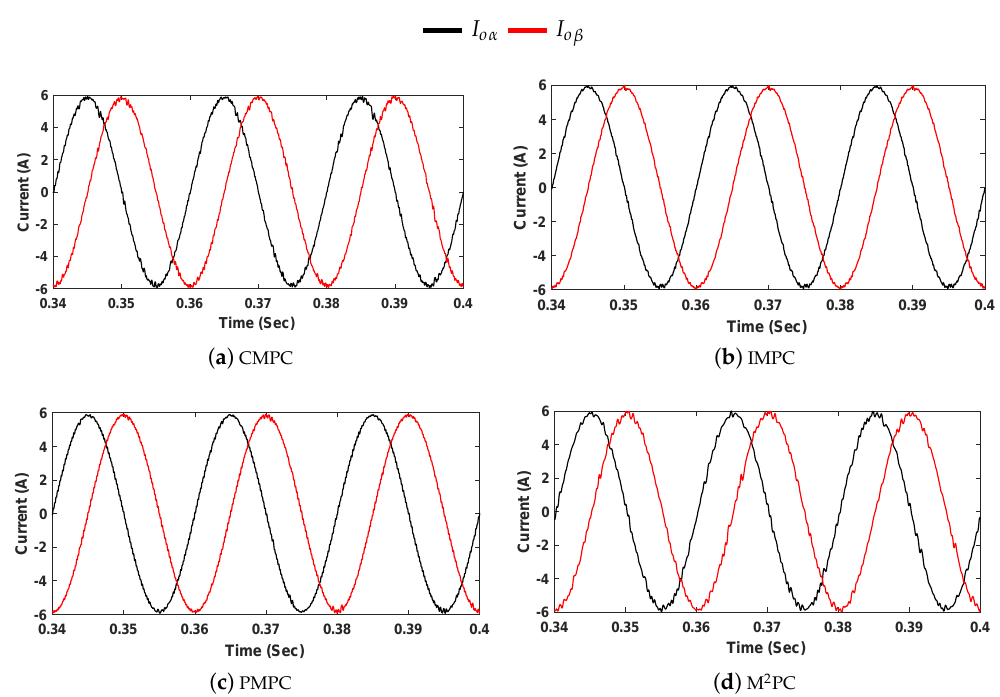
Figure 6. Obtained I o αβ currents using different MPC schemes, where the output power is 4 kW. ( a ) Conventional predictive scheme; ( b ) improved scheme from the conventional way; ( c ) periodic MPC scheme; and ( d ) MPC scheme with modulator.